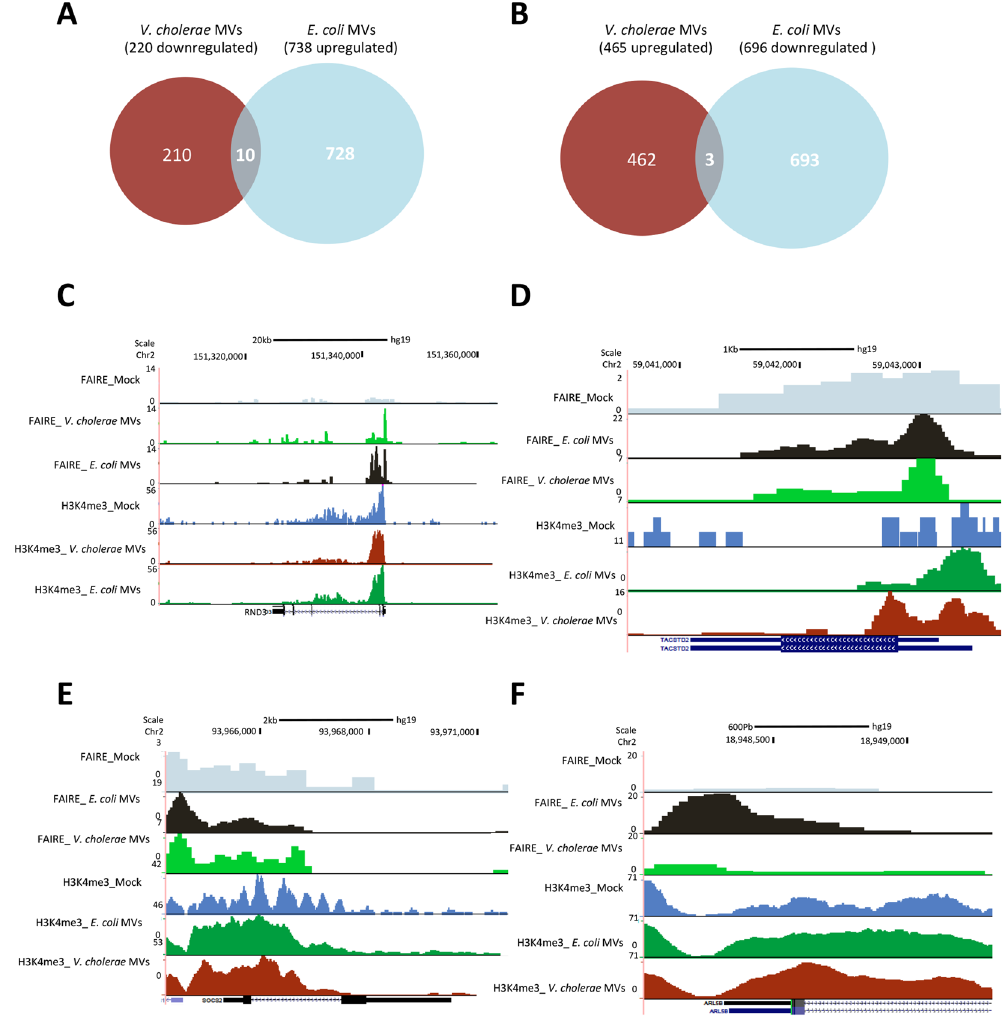
Figure 4. Influence of MVs on differentially regulated gene transcripts in HCT8 colorectal cancer cell line. ( A ) Venn Diagram showing the overlap of genes upregulated by E. coli MVs and downregulated by V. cholerae MVs. ( B ) Venn Diagram showing the overlap of genes downregulated by E. coli MVs and upregulated by V. cholerae MVs. ( C – F ) Examples of gene transcripts regulated in opposite way: ( C ) RND3 ( E. coli up and V. cholerae down), ( D ) TACSTD2 ( E. coli up and V. cholerae down), ( E ) SOCS2 ( E. coli up and V. cholerae down) and ( F ) ARL5B ( E. coli down and V. cholerae